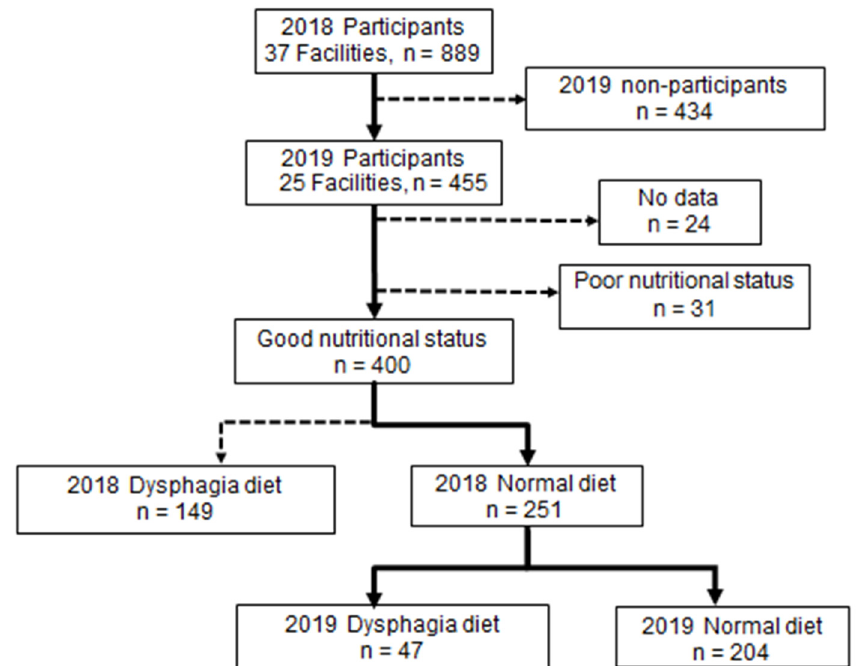
Figure 1. Flow chart of study participation.